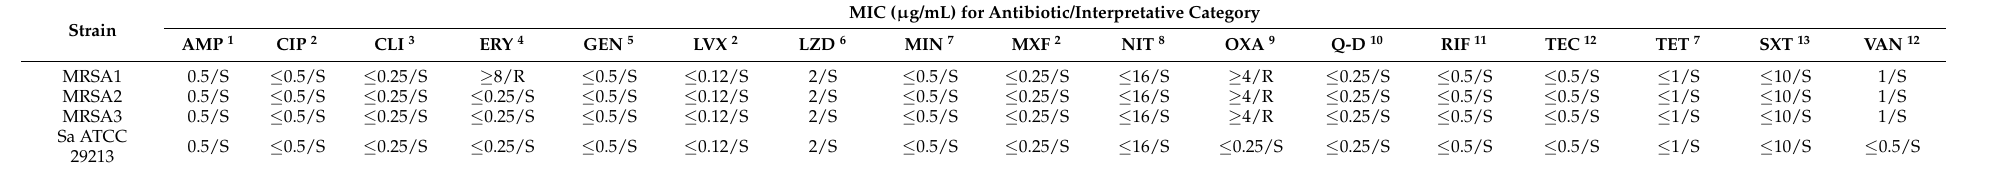
Table 2. Antimicrobial susceptibility and resistance profiles of methicillin-resistant S. aureus